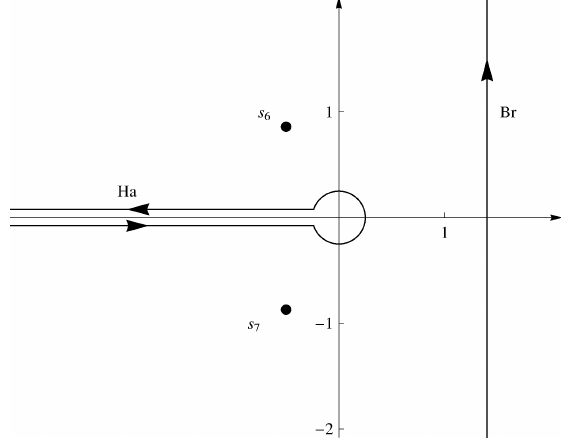
Fig. 1. The Bromwich path, Hankel path and the simple poles s 6 and s 7 for the fractional